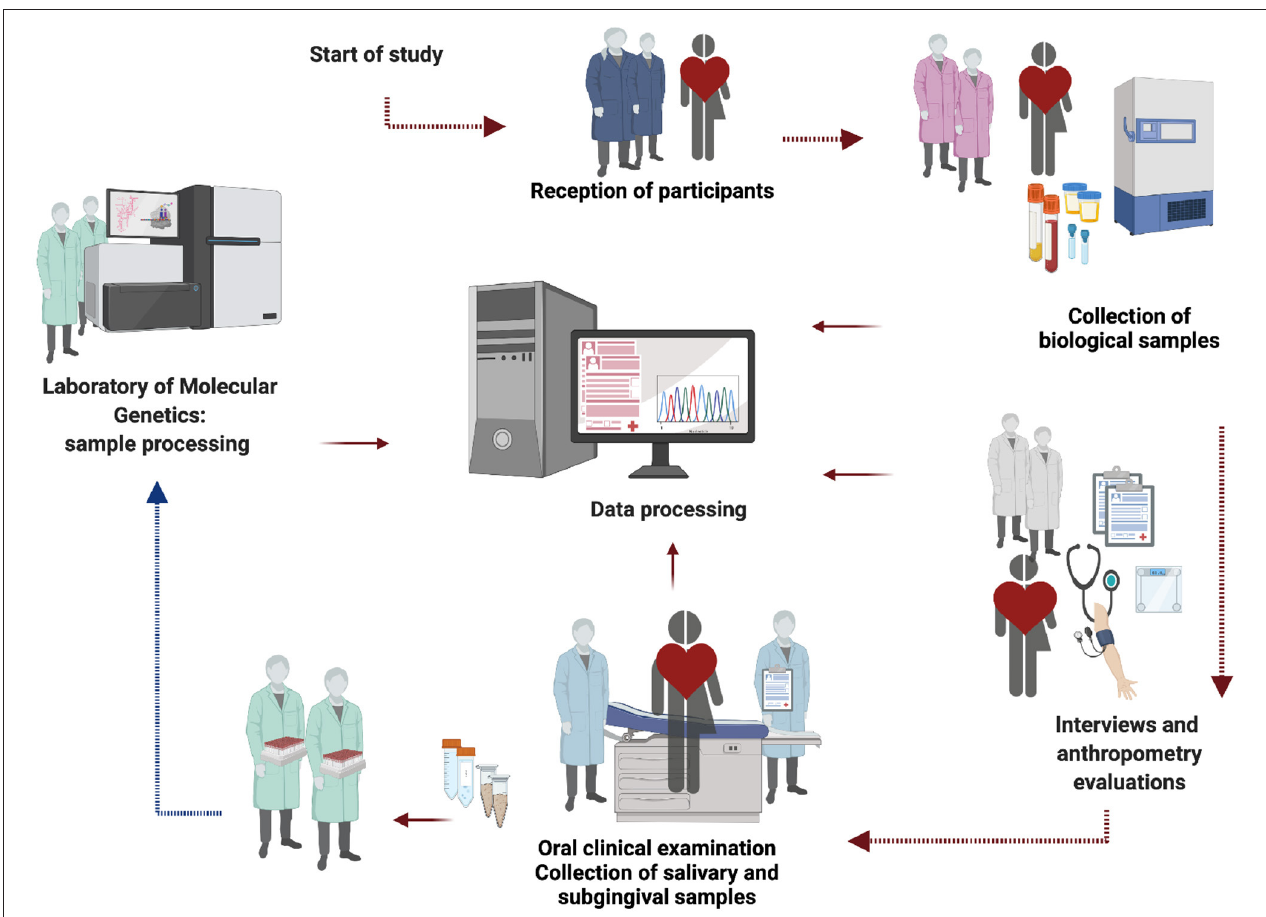
FIGURE 2 | Flow chart of study. The figure represents an interview sequence, sampling procedures and data management that will be carried out in the protocol. The image generated by the authors was created with the BioRender App.